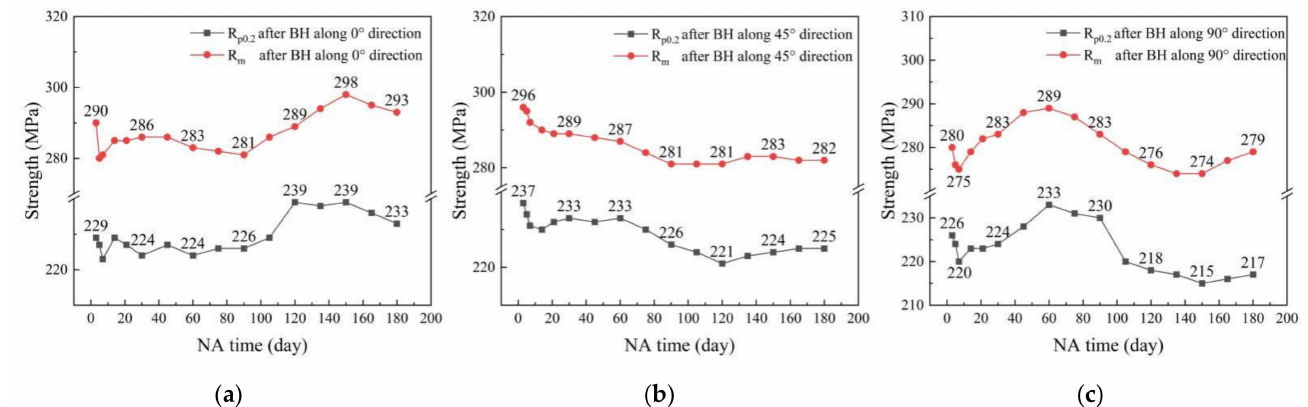
Figure 11. The change curves of R p0.2 and R m after bake hardening (BH) along 0 ◦ ( a ), 45 ◦ ( b ), and 90 ◦ ( c ) directions. Even though the strength changes after bake hardening along the three directions are different, the values of R p0.2 /R m along the three directions remain relatively stable throughout the six-month NA process. Figure 12 shows the change curves of R p0.2 /R m obtained by bake hardening along the three directions after different NA times. It can be seen that almost all the values of R p0.2 /R m are between 0.78 and 0.82. Along the 0, 45 and 90 ◦ directions, the average values of R p0.2 /R m are, respectively, 0.799, 0.799, and